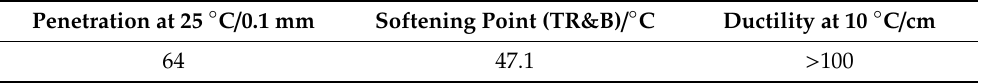
Table 6. Physical properties of virgin asphalt binder.